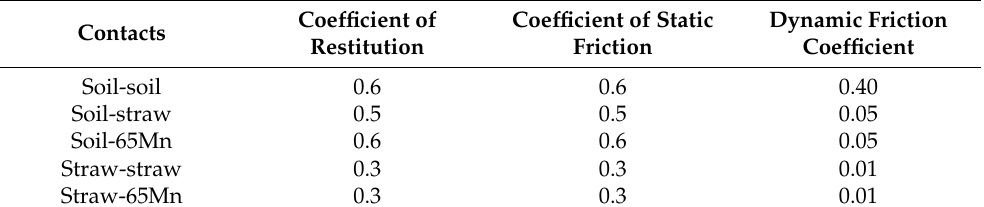
Table 3. Contact parameters.